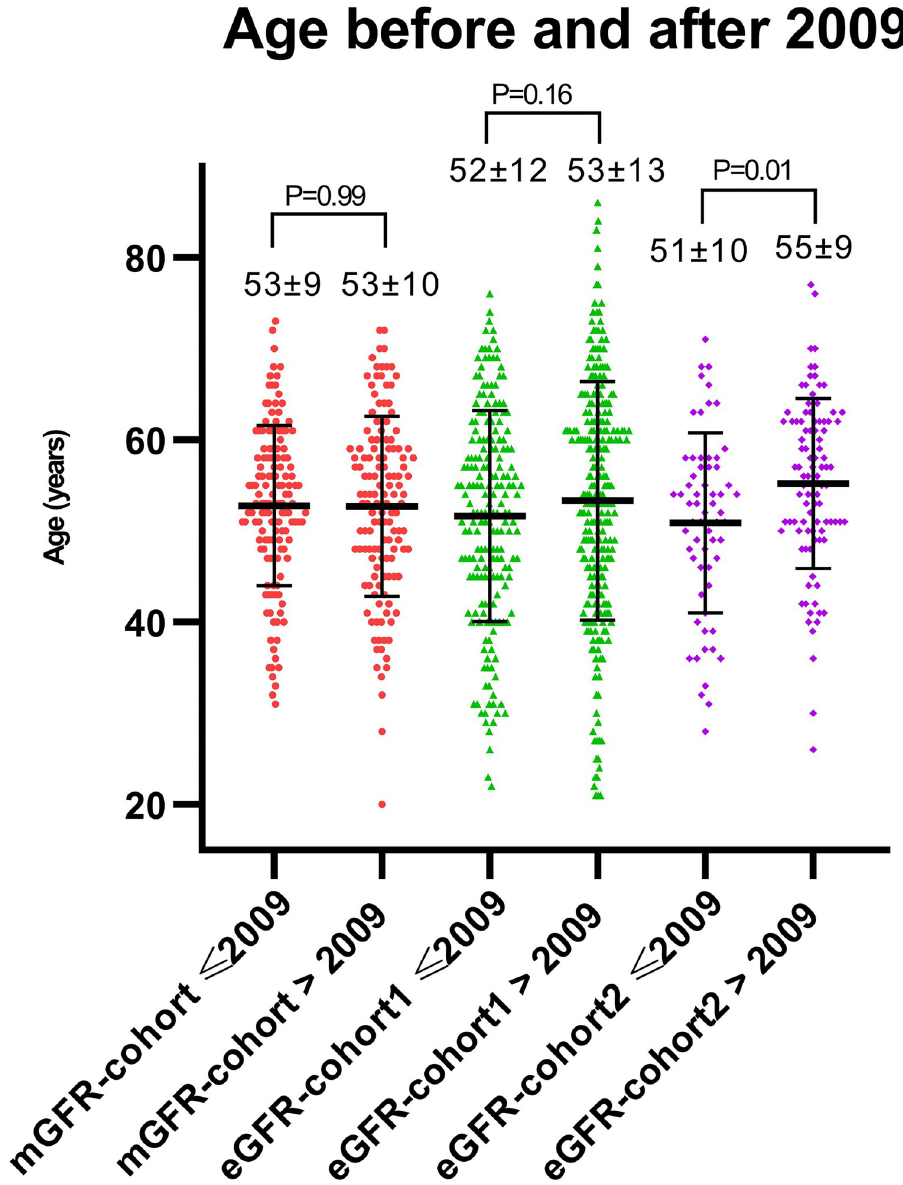
Fig 4. Distribution of age before and after 2009 per center. Differences between mean age were tested using the independent sample T-test, P-values are shown in the